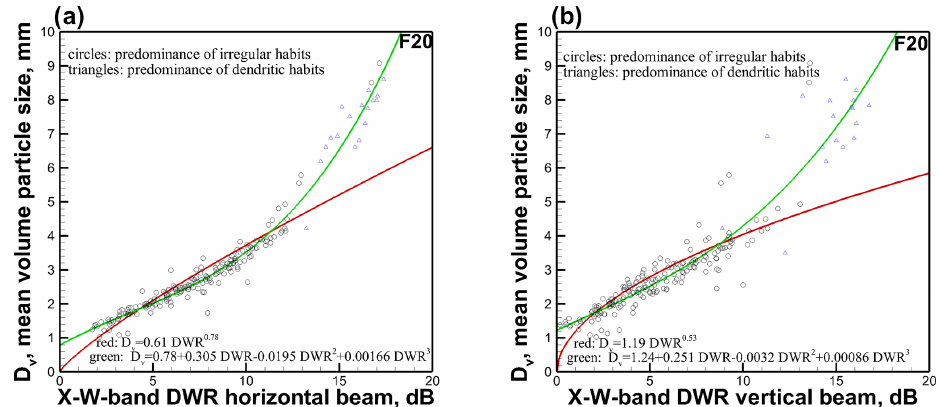
Figure 4. Scatter diagrams of the mean volume particle size vs. X–W-band DWR for (a) horizontal radar beam pointing and (b) vertical radar beam pointing during flight 20 measurements at the 250m range gate. Best-fit power-law (red lines) and polynomial (green lines) approximations for all habits are also